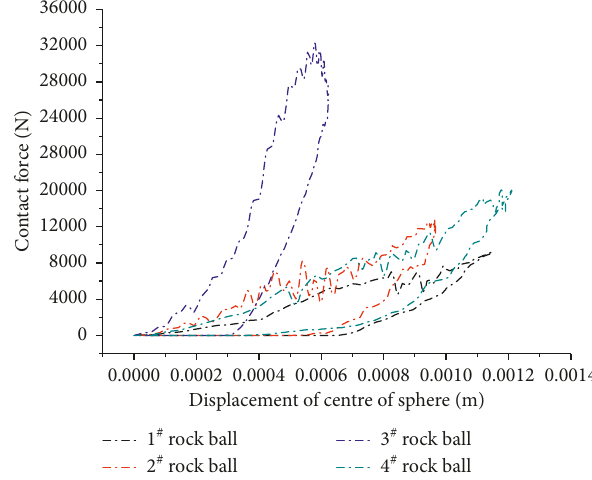
Figure 17: Simulation curves of contact force-DCS at